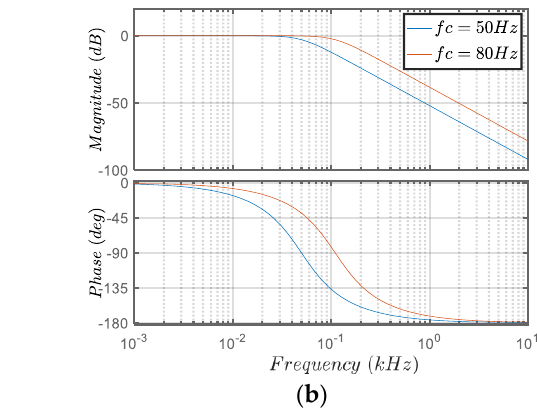
Figure 12. Simulation waveforms: ( a ) harmonic spectrum of the estimated back EMF of the 3rd har- monic TM, ( b ) Bode diagram of the second order low pass filter.